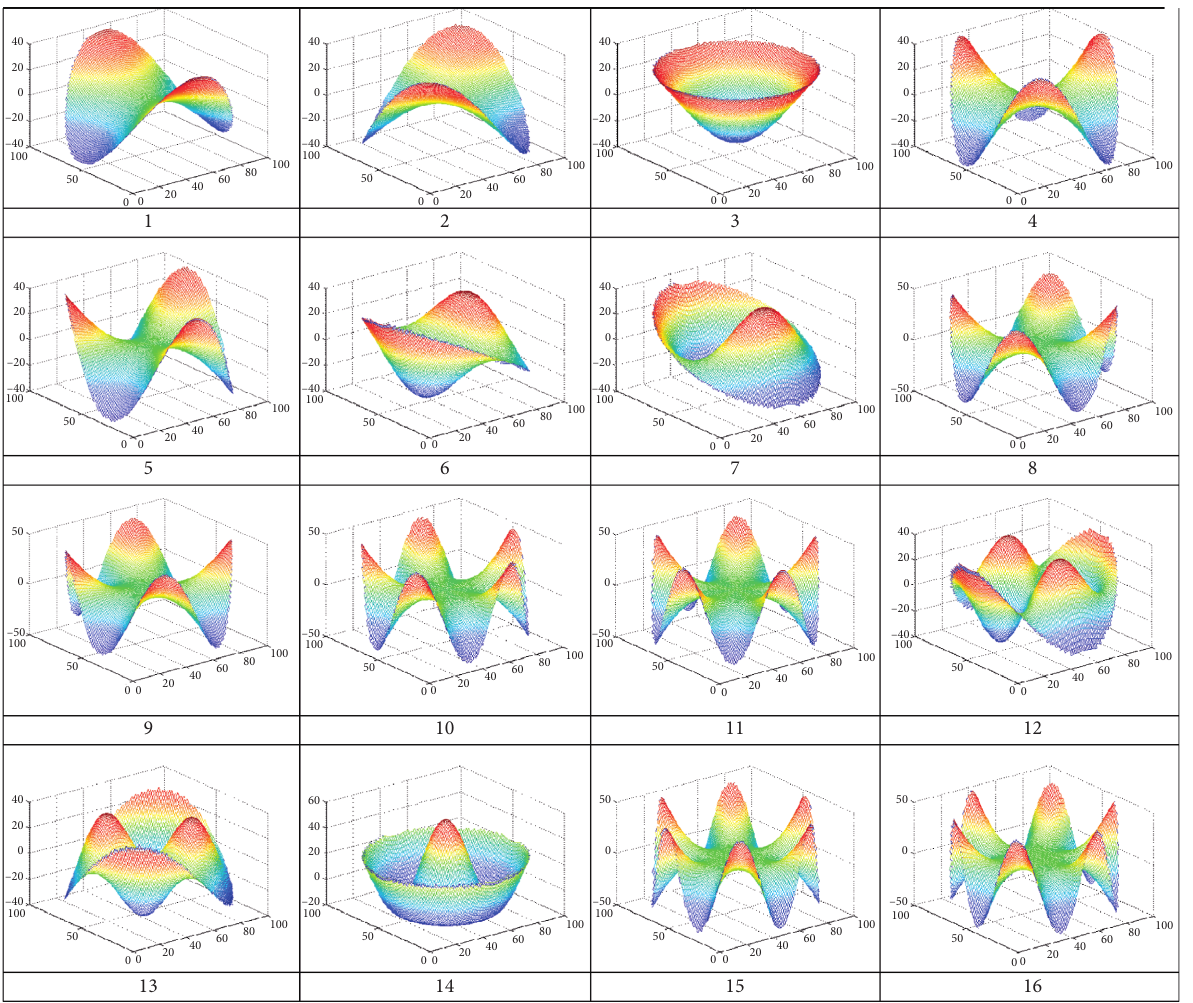
Figure 2: The first 16 vibration mode shapes of the